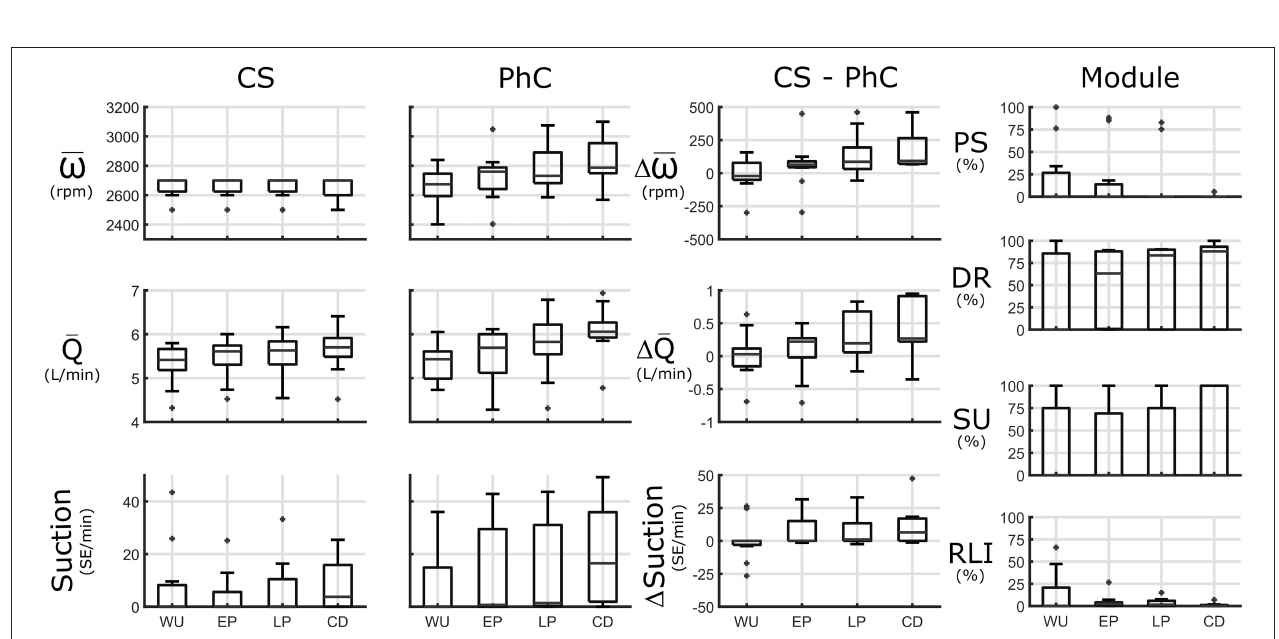
FIGURE 6 | Submaximal ergometry is subdivided into 4 phases: warm up (WU), early phase (EP), late phase (LP) and cool down (CD). Left panels: Speed ( ω ), flowrate (Q), and suction [in Suction Events (SE)/minute] in constant speed (CS) and physiologic control (PhC) and their differences are presented. Module panel: control module activation: activation for pulsatility (PS), demand response (DR), suction response (SU), and rate limited increase (RLI) modules. Speed during ergometry is increased in PhC compared to CS resulting in increased pump flowrates, especially at later stages of submaximal exercise.